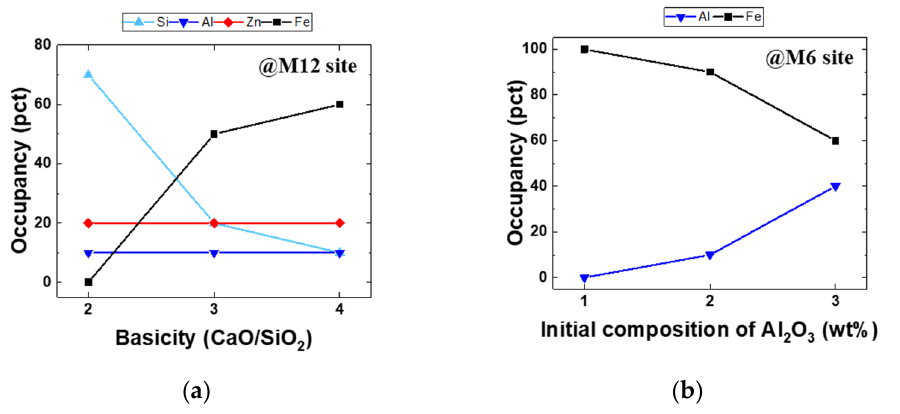
Figure 11. Atom occupancy changes at M12 and M6 sites ( a ) as a function of the basicity and ( b ) relative to the initial composition of Al 2 O 3 [50].